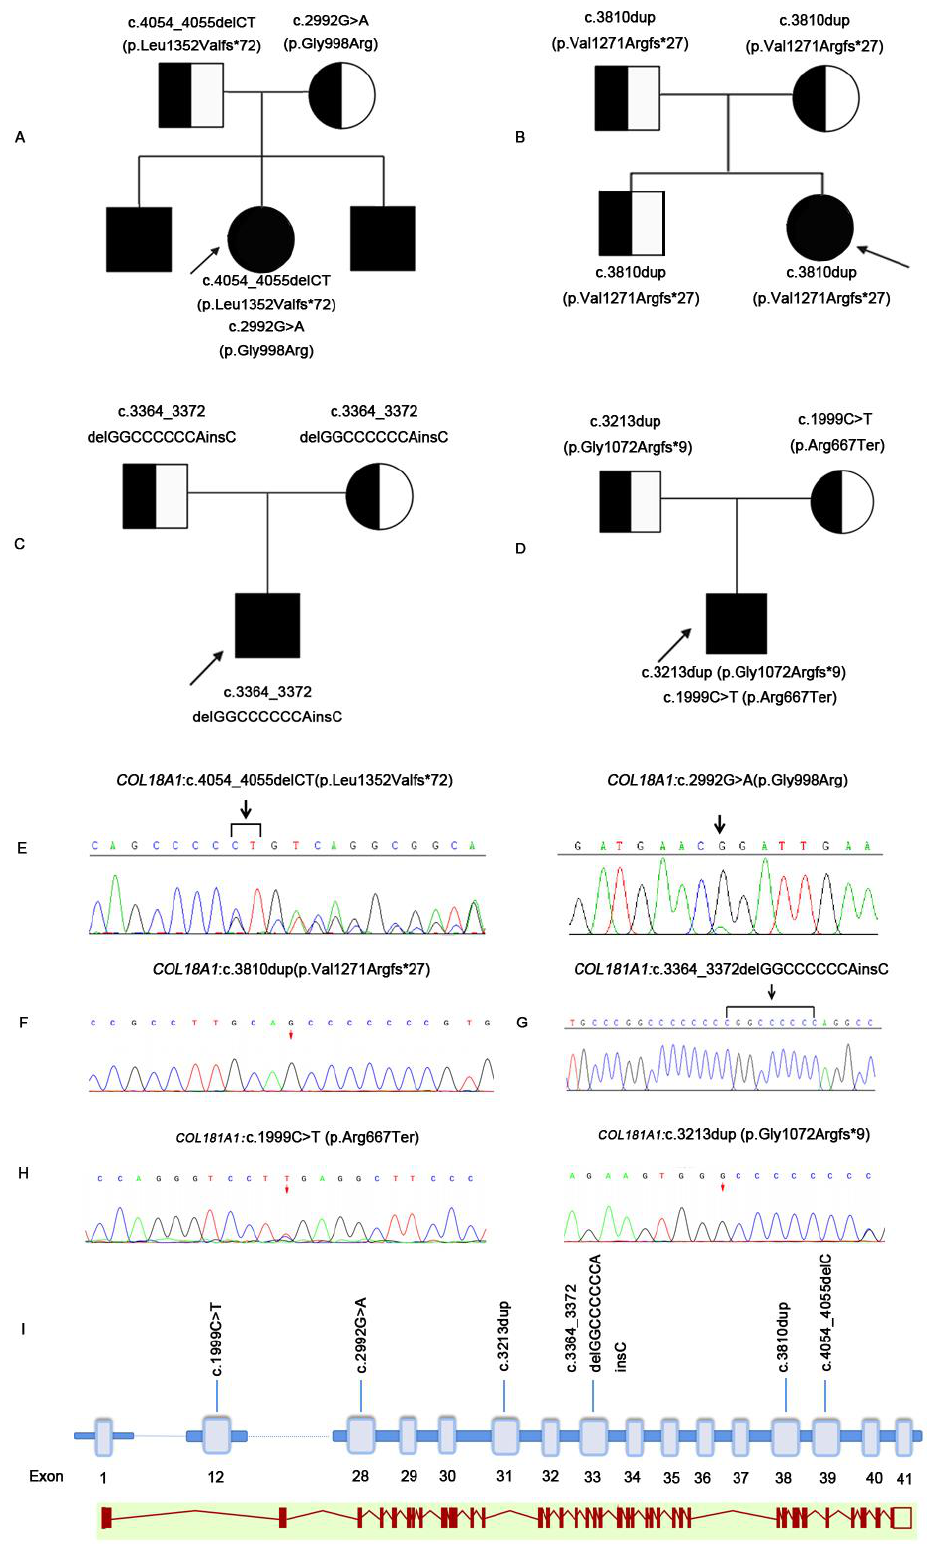
Figure 3. Pedigrees and genetical changes of families affected by Knobloch Syndrome. Two homozy- gous and two complex heterozygous mutations in COL18A1 were identified. Patient 1: ( A , E ). Patient 2: ( B , F ). Patient 3: ( C , G ). Patient 4: ( D , H ). The exon–intron structure and the variants in this study were shown on the scheme ( I